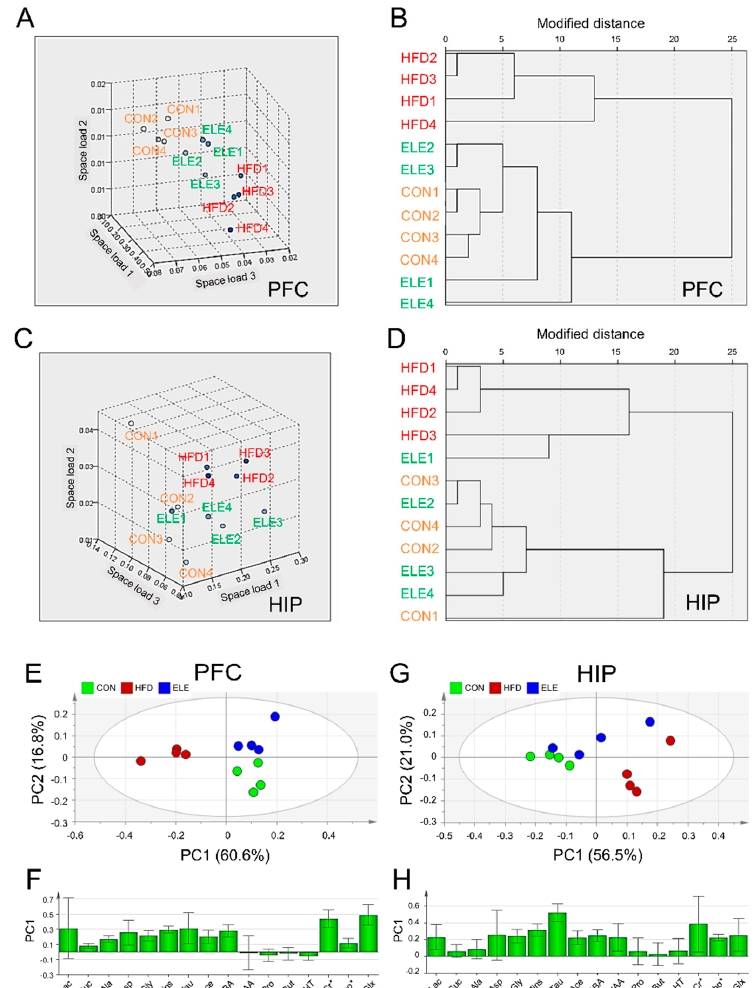
Figure 2. Cluster analysis and principal component analysis of mouse brain metabolites in different treatment groups. ( A , B ) Nearest neighbor analysis ( A ) and hierarchical cluster analysis ( B ) of PFC. ( C , D ) Nearest neighbor analysis ( C ) and hierarchical cluster analysis ( D ) of HIP. ( E , F ) Principal component analysis (PCA) score plot ( E ) and principal component 1 (PC1) loading plot ( F ) of PFC. ( G , H ) PCA score plot ( G ) and PC1 loading plot ( H ) of HIP. The spots with the same color are derived from the same kind of samples. CON, normal diet; HFD, high-fat diet; and ELE, HFD-induced obese mice under treatment with β -elemene ( n = 4). Cr*, Cr + PCr; Cho*, Cho + PCho; and Glx, Glu +